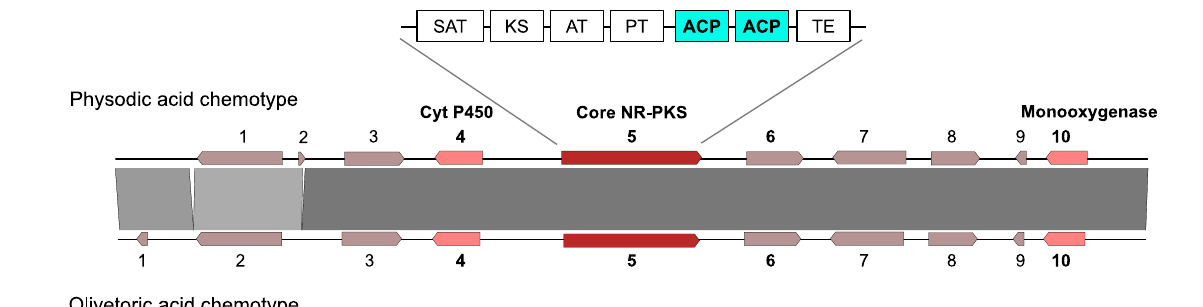
Figure 3. Synteny plot based on tBLASTn depicting conservation and synteny between the homologous putative cluster for the synthesis of the depsidone physodic acid and the depside olivetoric acid in P. furfuracea . Bolded numbers represent the genes that are predominantly expressed. Domains of the PKS are schematized on top.